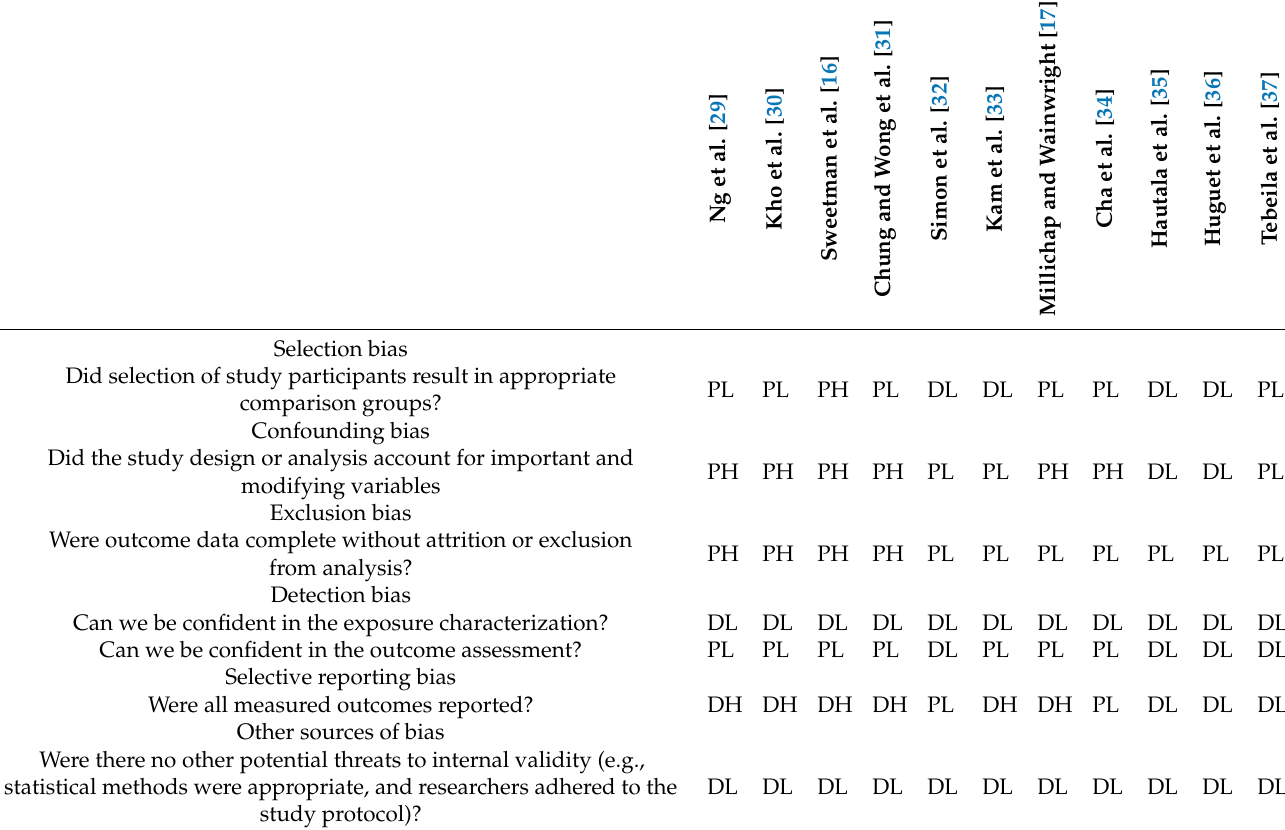
Table 4. Summary of risk of bias assessment according to the risk of bias (ROB) tool from the